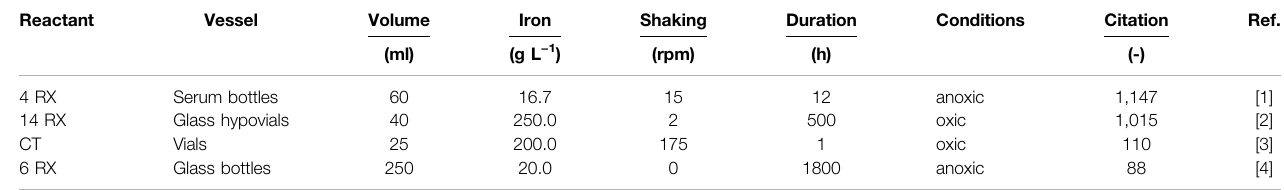
TABLE 3 | Summary of some experimental conditions used for batch experiments in the four fi rst peer-reviewed articles using metallic iron (Fe 0 ) for contaminant removal. Chlorinated hydrocarbons were used with various initial concentrations. CT stands for carbon tetrachloride. “ Citation ” is the number of independent citations (excluding self-citations) according to Scopus (www.scopus.com: February 25, 2021).